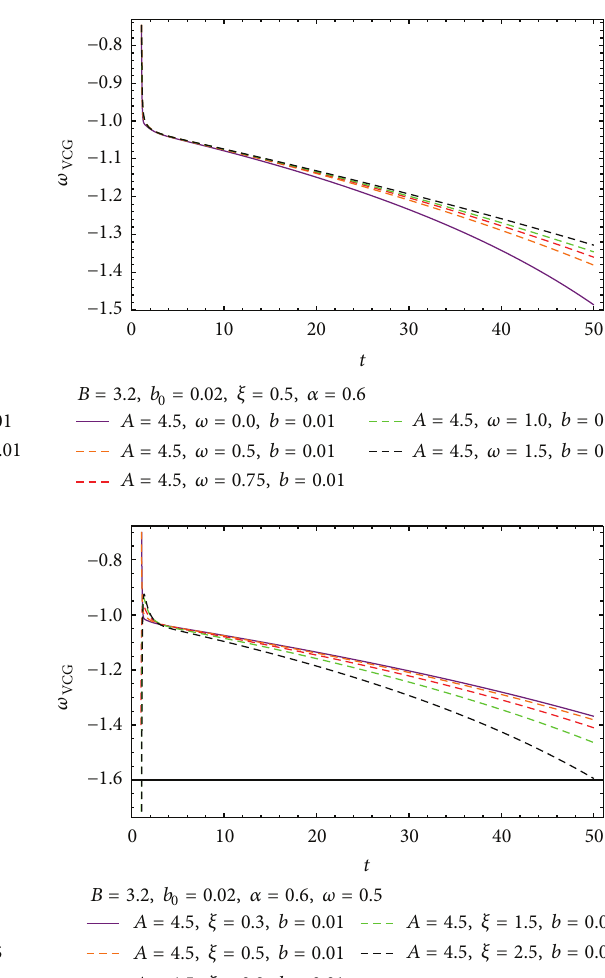
Figure 7: Behavior of EoS parameter of viscous Chaplygin 𝜔